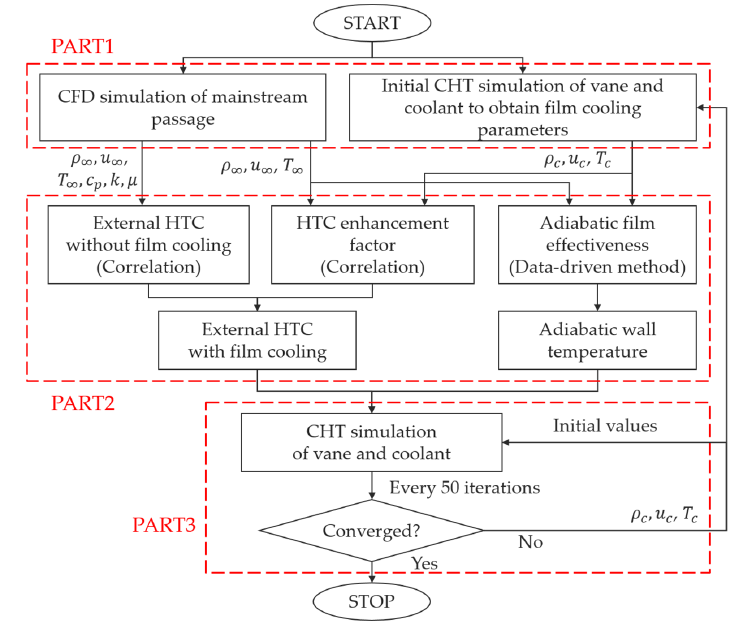
Figure 2. Iterative strategy of the decoupled CHT method.